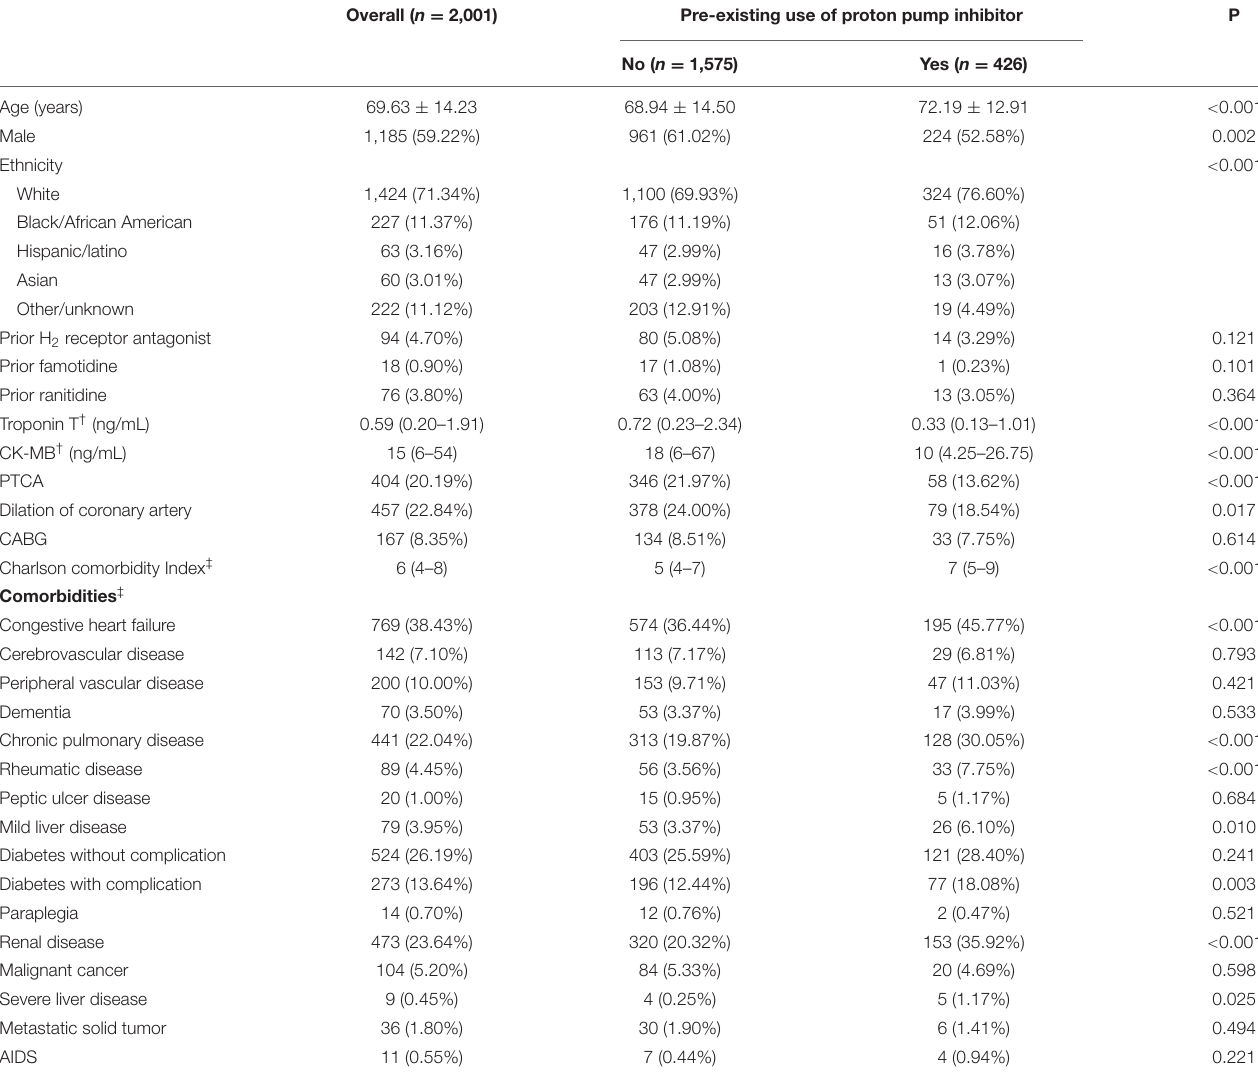
TABLE 1 | Clinical characteristics of the study